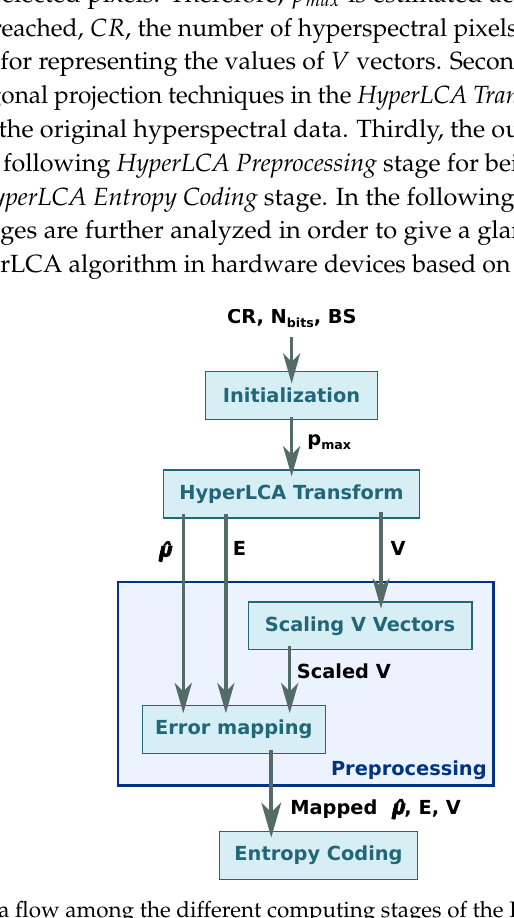
Figure 1. Data flow among the different computing stages of the HyperLCA